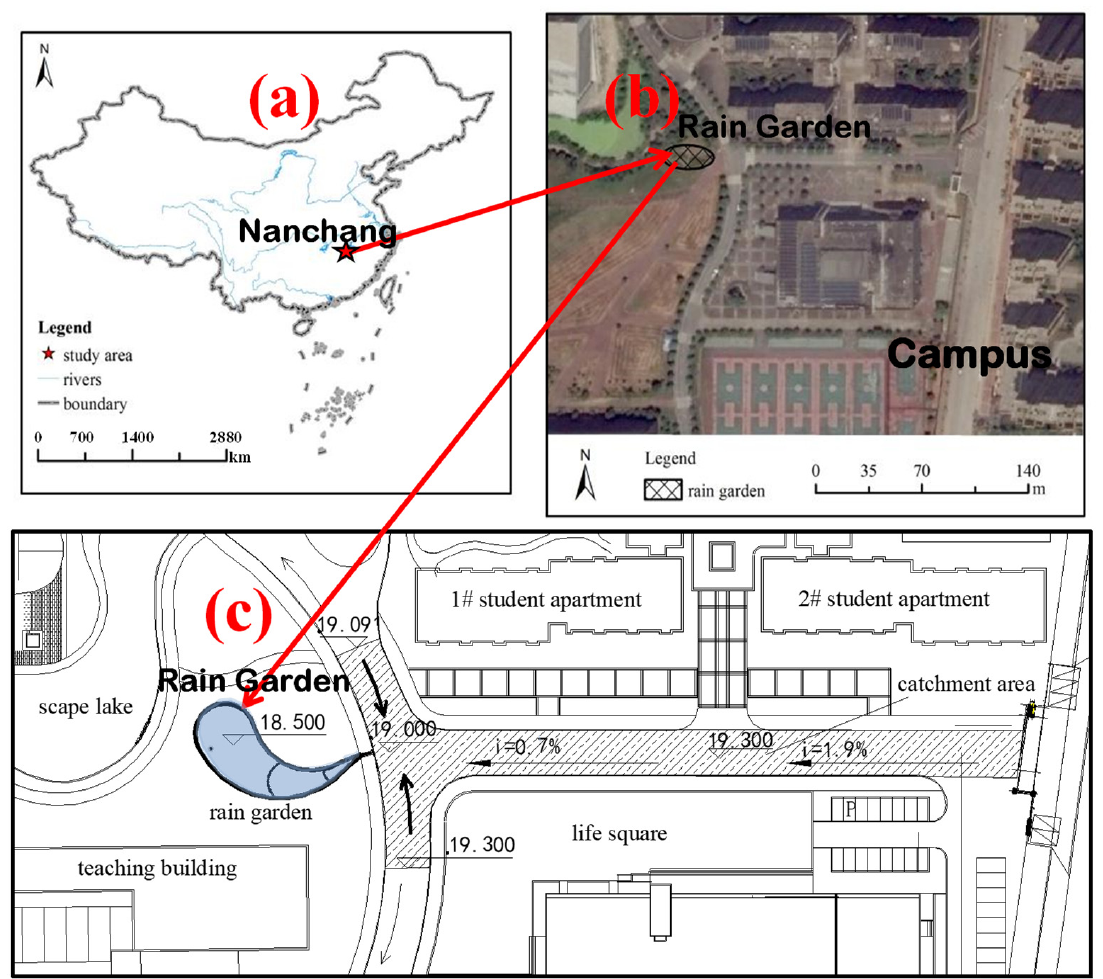
Figure 1. Location map of the rain garden ( a ) The location of Nanchang in China; ( b ) The location of the rain garden in Nanchang; ( c ) The location and surrounding schematic of the rain garden.